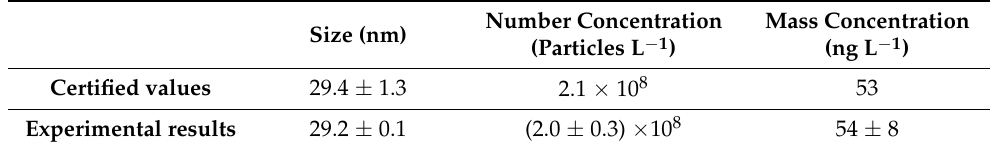
Table 3. Particle size, particle number, and mass concentration for the reference sample of Au nanoparticles ( n = 3).